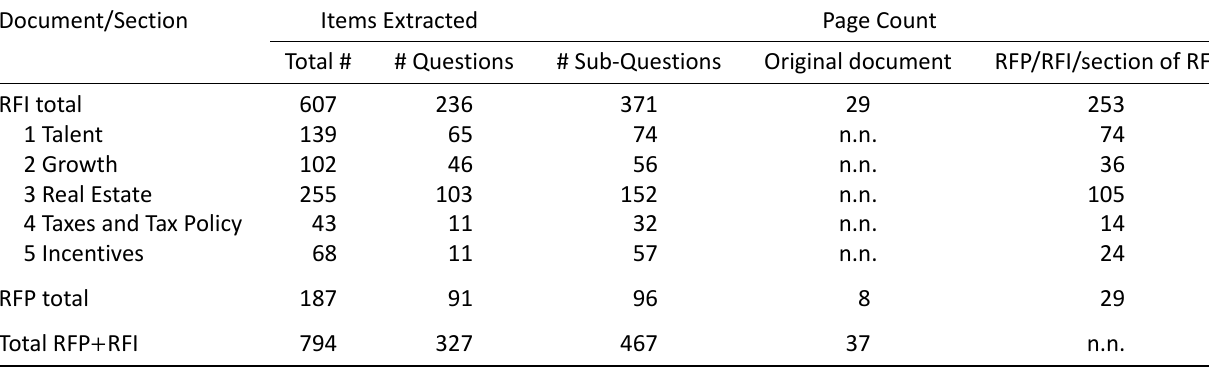
Table 2. Quantitative dimensions of documents RFP and RFI.